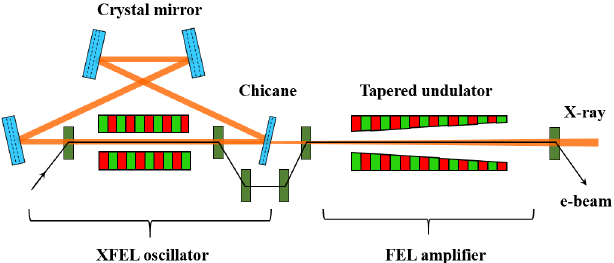
FIG. 1. The schematic of XFELO seeded